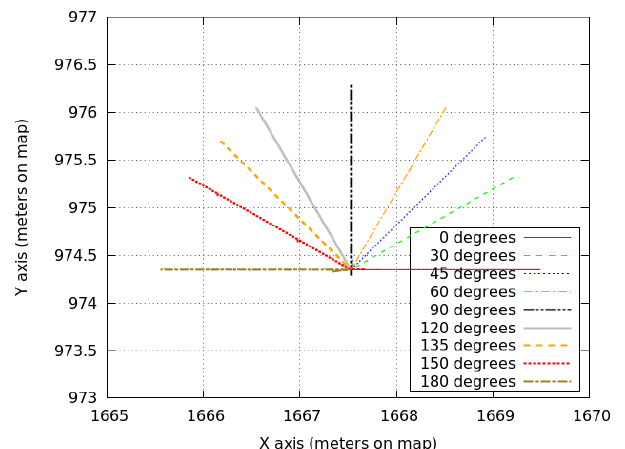
Figure 16. Path of host at different start angles